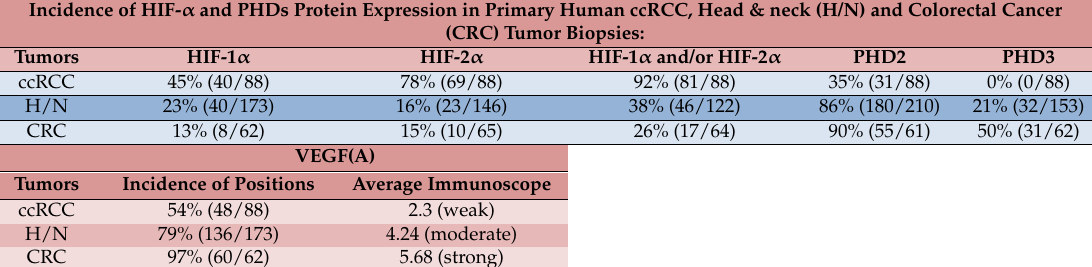
Table 1. Molecular profile of tumor biopsies.